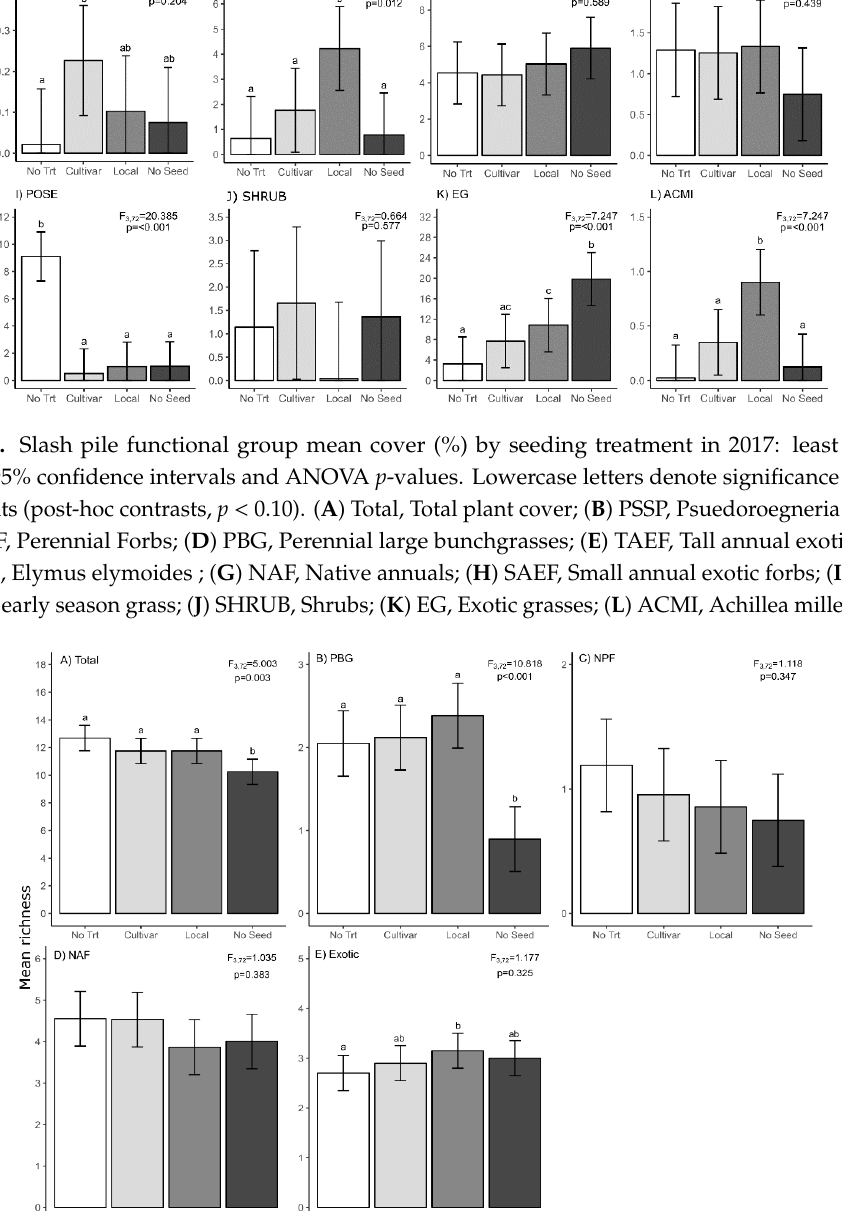
Figure 5. Slash pilefunctional group mean richness by seeding treatment in 2017: least square means, 95% confidence intervals and ANOVA p -values. Lowercase letters denote significance among treatments (post-hoc contrasts, p < 0.10). All perennial bunchgrasses (PBG), native perennial forbs (NPF), native annual forbs (NAF), all exotics (Exotic). ( A ) Total, Total plant cover; ( B ) PBG, Perennial large bunchgrasses; ( C ) NPF, Perennial Forbs; ( D ) NAF, Native annuals; ( E ) xotic, all